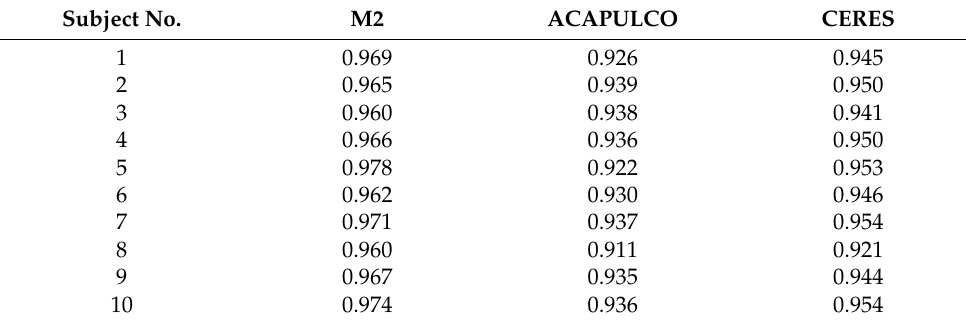
Table 10. DSC comparison between the approaches, in DLBS